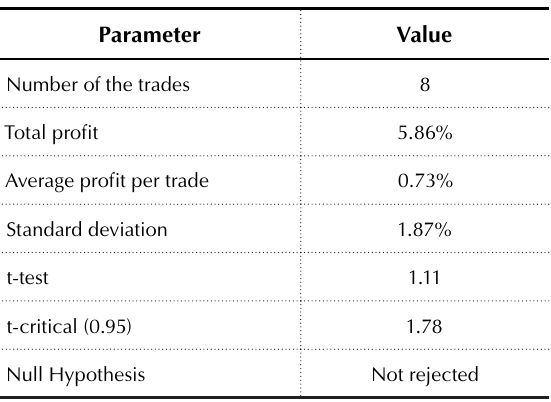
Table 9. T -test for evaluating the success of the trading strategy: PFST returns over the period 1991–2018, social force majeure and terrorist acts, period